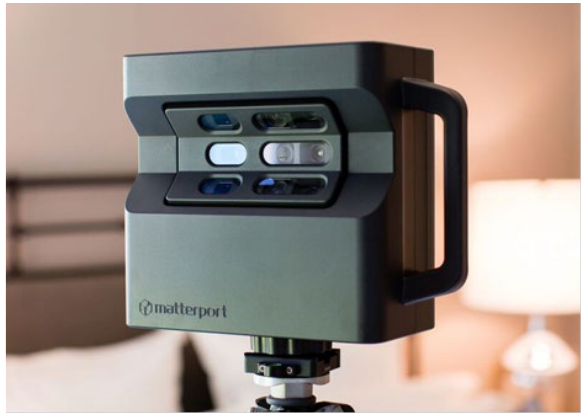
Figure 1. Matterport Pro 3D Camera (Matterport, 2019b)